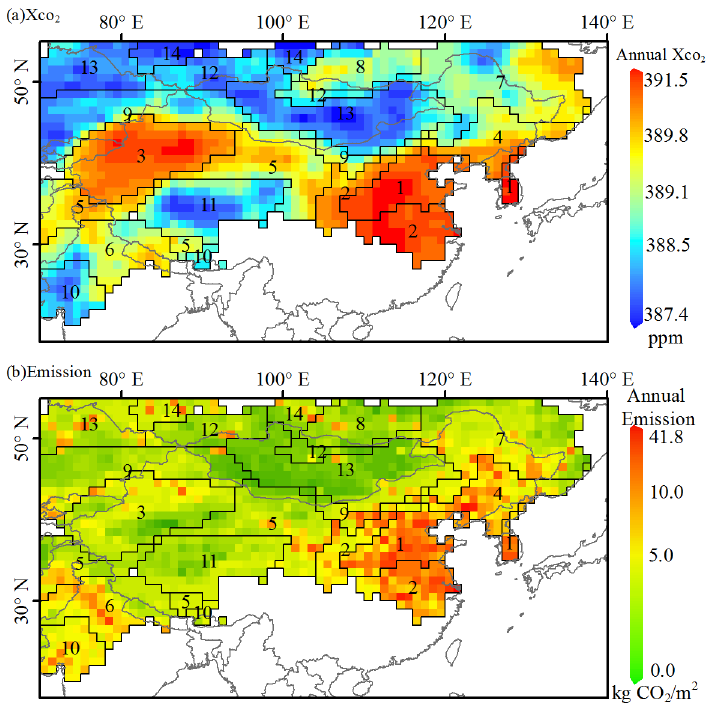
Figure 4. ( a ) Annual Xco ; ( b ) Annual CO 2 emissions in 2010 overlapped with the optimal 2 cluster result (black lines).